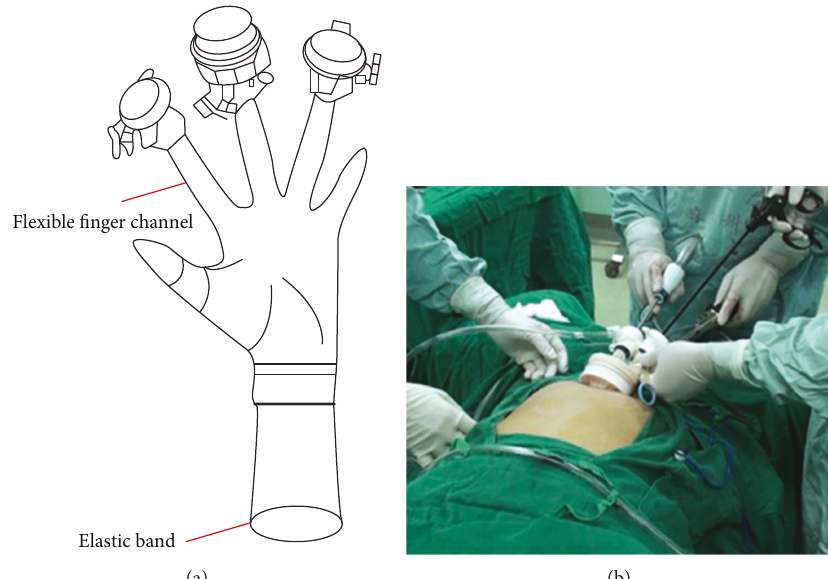
Figure 2: The device used in single-port laparoscopic hepatic left lateral sectionectomy. (a) The “ glove-shape ” trocar with fi ngers, allowing laparoscopy and di ff erent instruments to pass through the umbilical port simultaneously during operation (b).